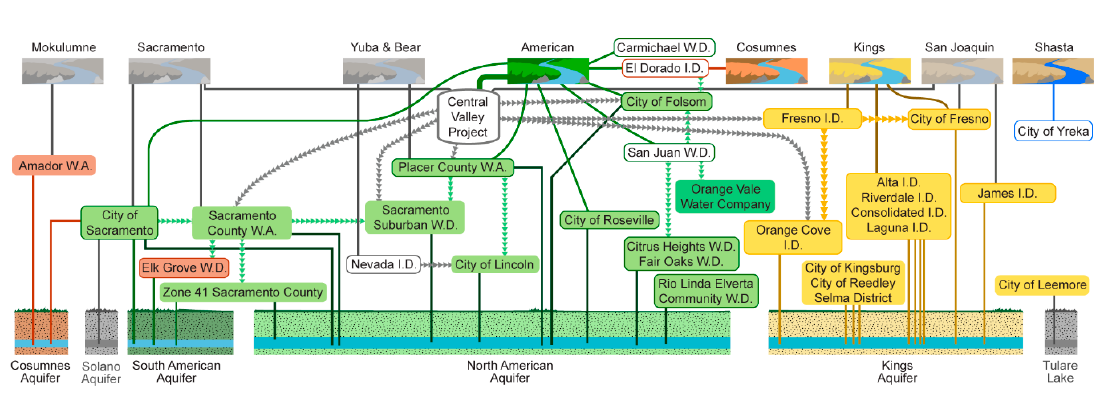
Figure 3. The water supply network, including surface and groundwater sources, in the four case study watersheds. Rivers are listed on the top, and aquifers are along the bottom. Shasta organizations are indicated by blue, American by green, Cosumnes by orange, and Kings by yellow. Solid lines indicate direct withdrawals, and dashed arrows indicate water purchases. Boxes with outlines indicate surface water use; shaded boxes indicate groundwater use. “I.D.” = Irrigation District; “W.D.” = Water District; “W.A.” = Water Agency.